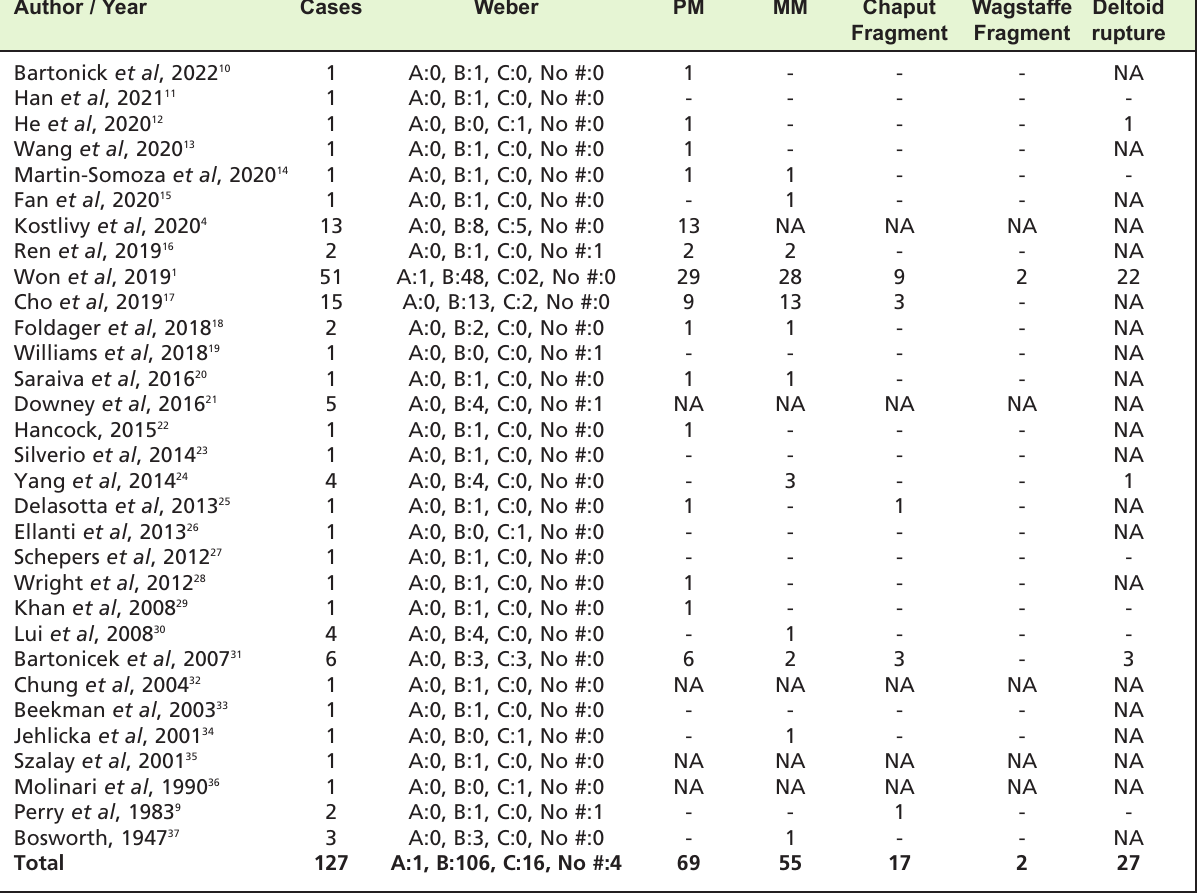
Abbreviations - PM: Posterior malleolus, MM: Medial malleolus, NA: Not Clearly Documented, - : None